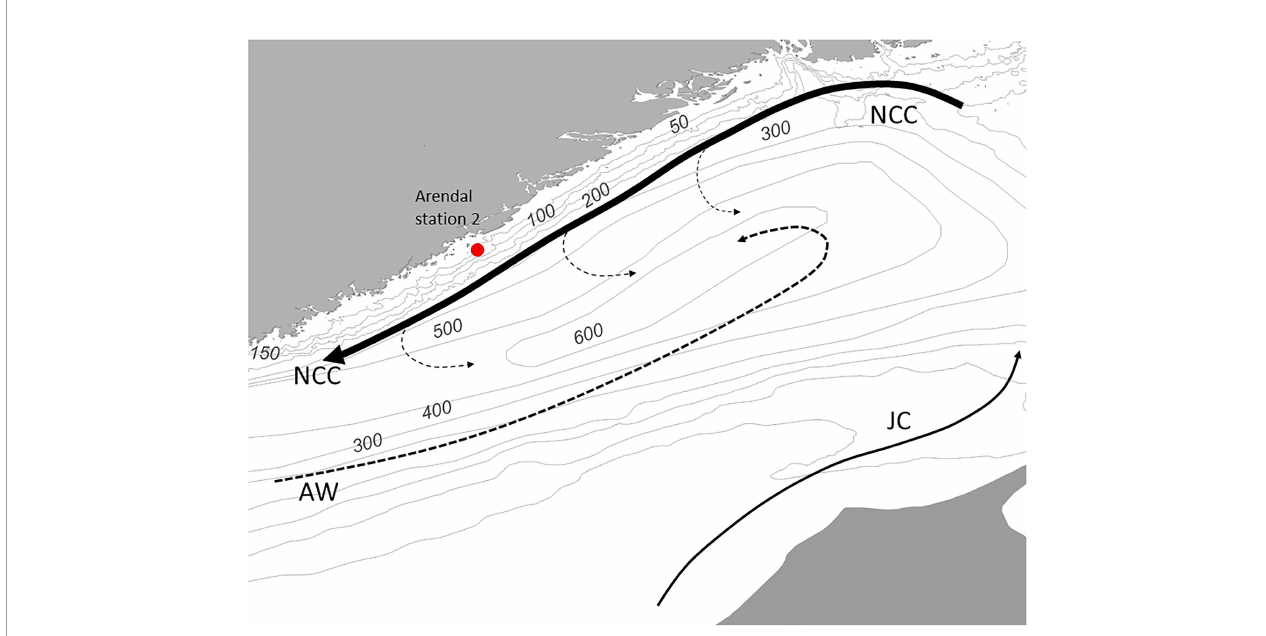
FIGURE 2 | Local bathymetry and prevailing circulation systems in Skagerrak. NCC, Norwegian Coastal Current; AW, Atlantic water; JC, Jutland